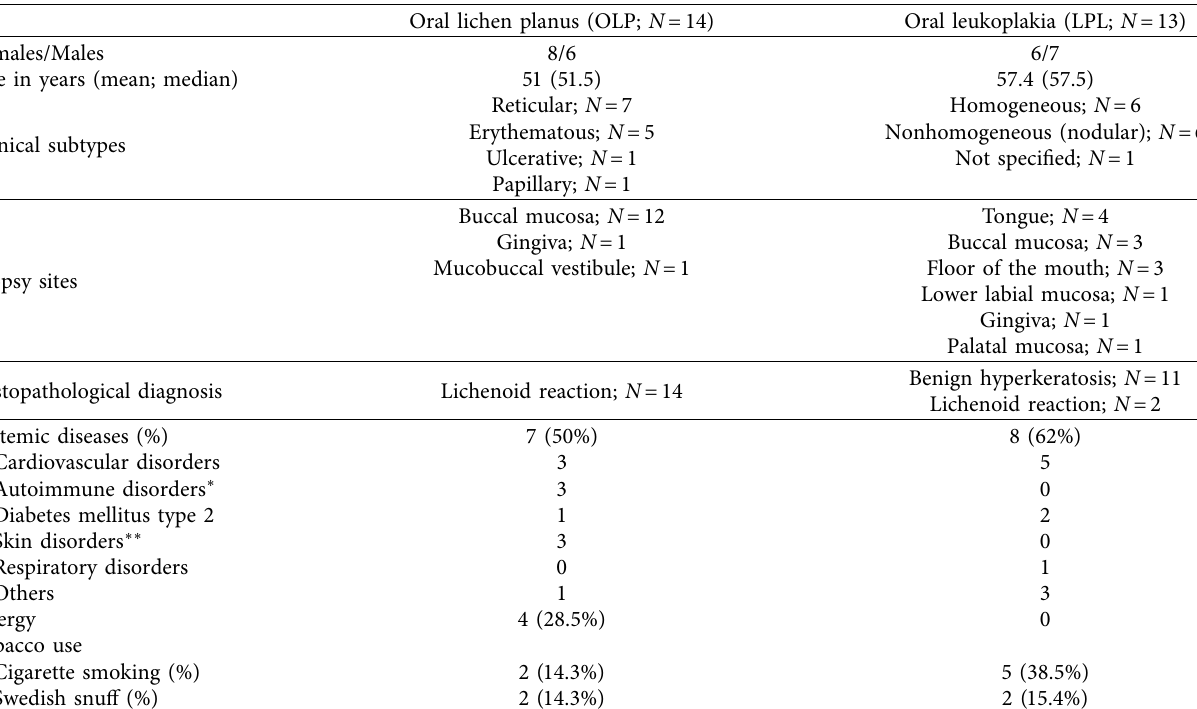
Table 1: Demographic and clinical characteristics of the study population.